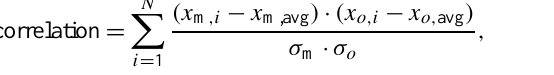
tom rows show results for January and August, respectively. The original EMEP model results are represented by grey dots, the smoothed EMEP results are shown as black solid lines, and the MOPITT retrievals and the a priori estimate are depicted as solid red and dashed blue lines,